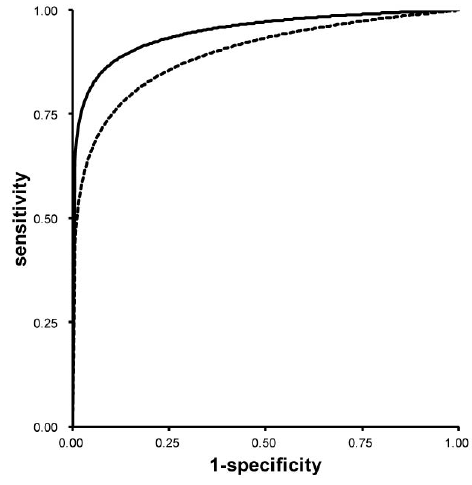
Figure 4. Fitted receiver-operating-characteristic (ROC) Curves. A ROC curve based on the PpIX fluorescence intensities analyzed by the spectral unmixing method is shown as a bold line . A ROC curve based on the PpIX fluorescence intensities analyzed by the spectral bandpass at the 640 nm is also depicted for comparison ( dotted line